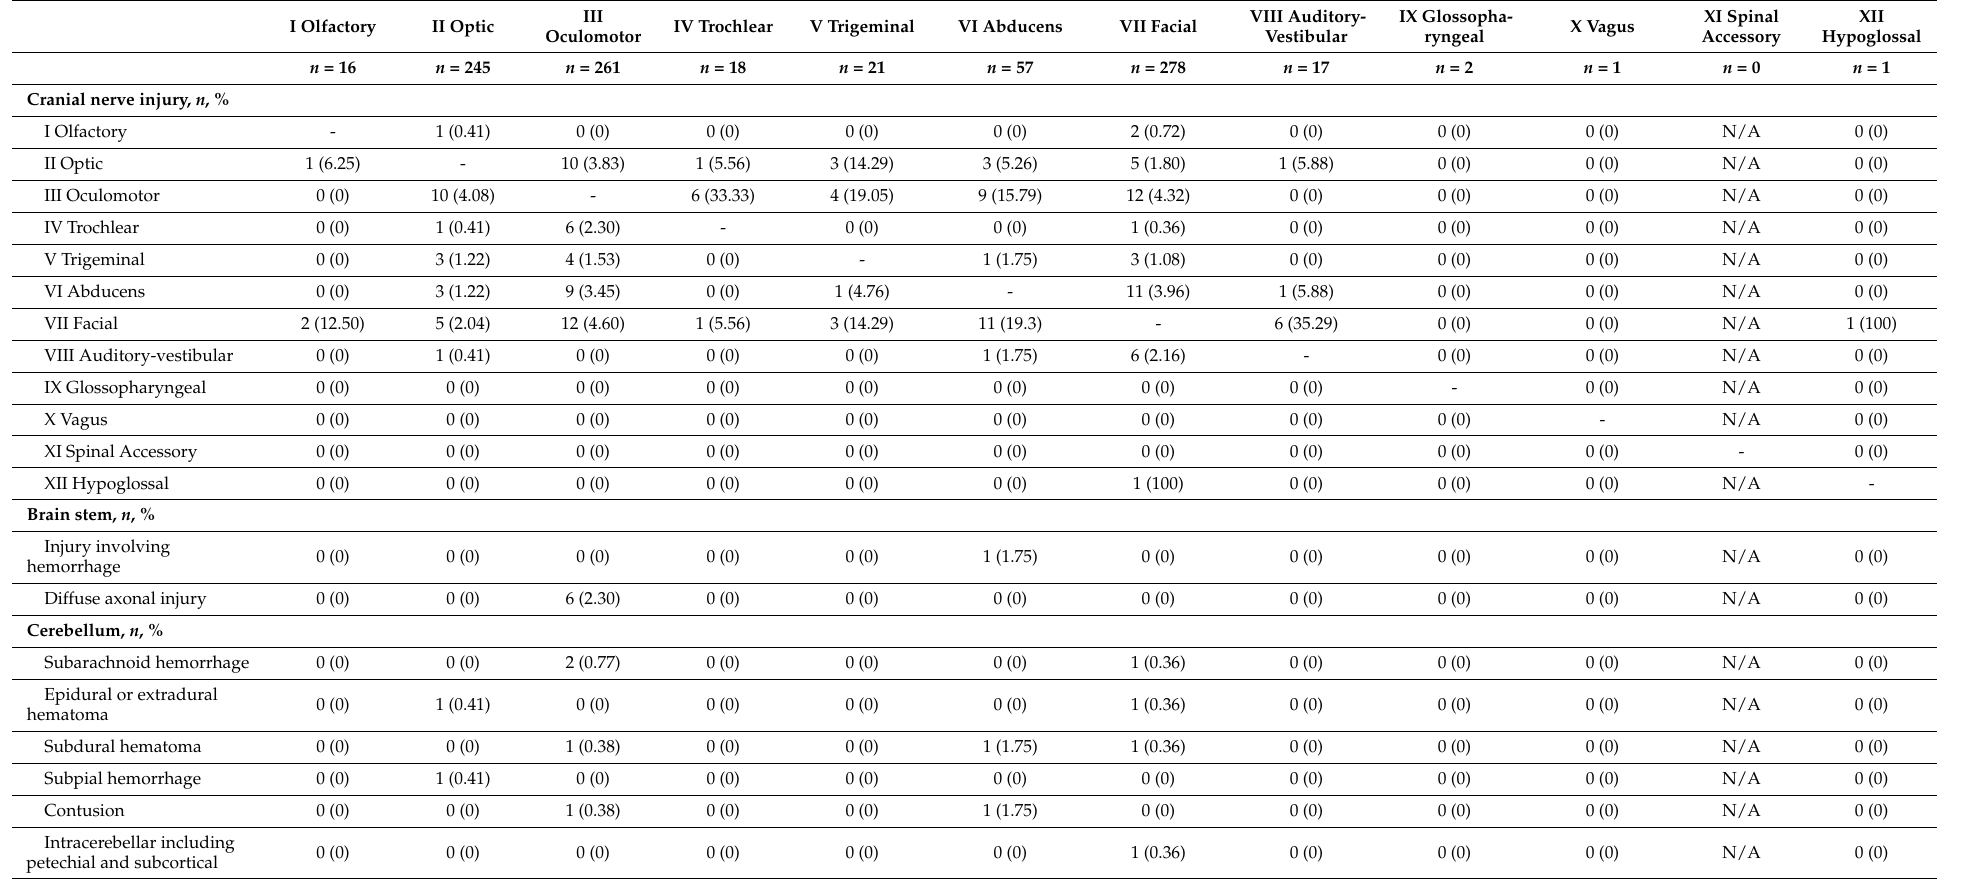
Table 4. Head trauma and facial bone fracture complicated with cranial nerve